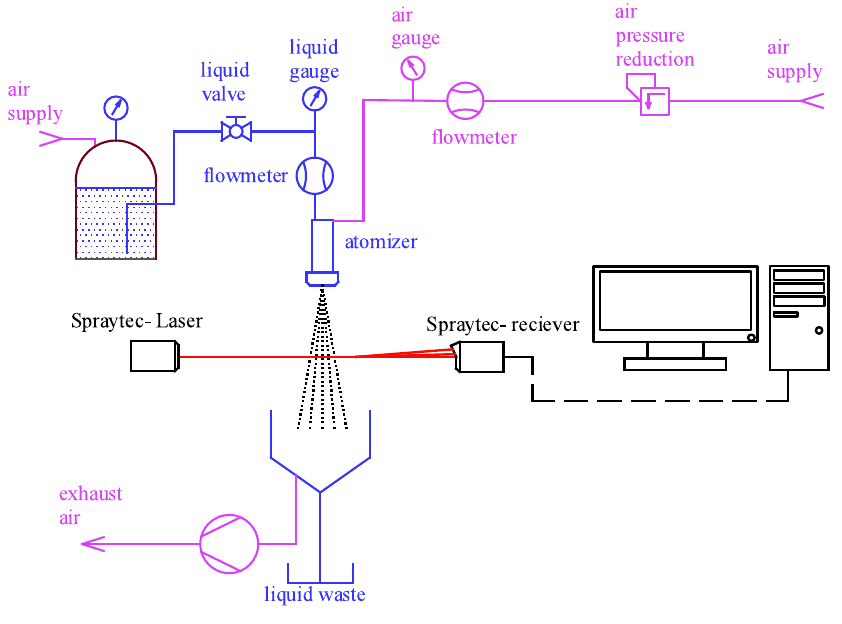
Figure 2. The test